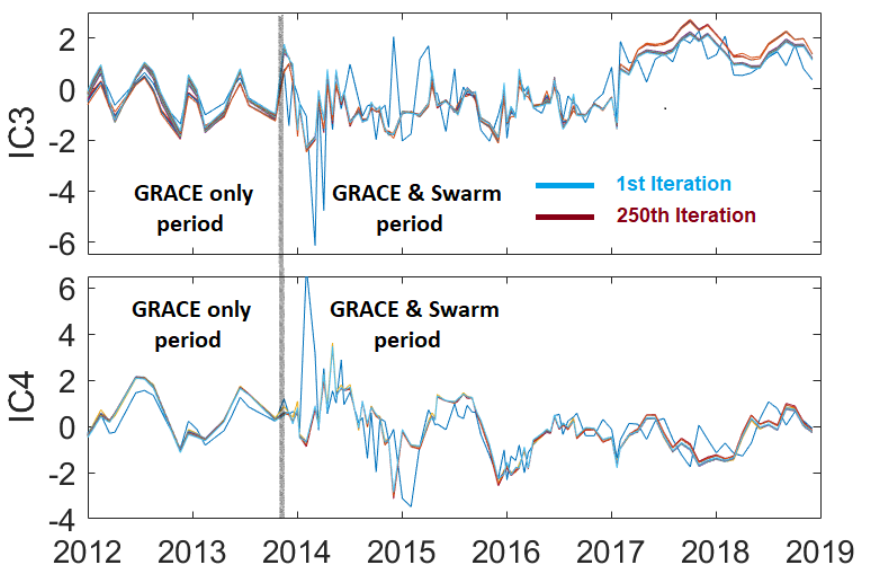
Figure 1. An overview of changes in empirical independent components (ICs), i.e., third (IC3) and fourth (IC4) independent components, through the iterations of Approach 2. To enhance the visualization, the iteration is limited to 250 and for the period of